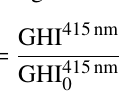
Figure 14. (a) Red radiance and (b) RBR for liquid clouds with τ a = 0, 0.078, and 0.2 and ice clouds with τ a = 0 . 078 vs. τ c for ϑ s = 45 ◦ , θ 0 = 60 ◦ , and ϑ z = 45 ◦